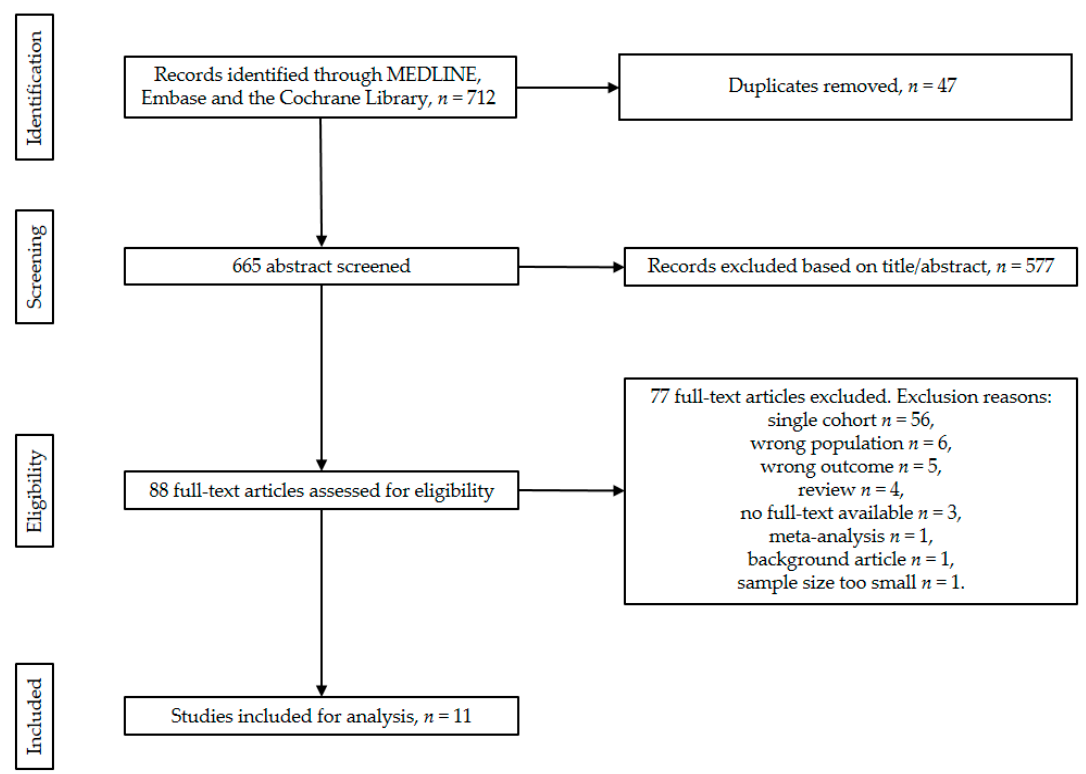
Figure 1. PRISMA flow chart of the study screening and selection process.